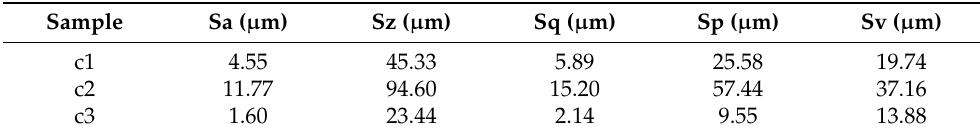
Table 3. Surface roughness parameters of different samples.